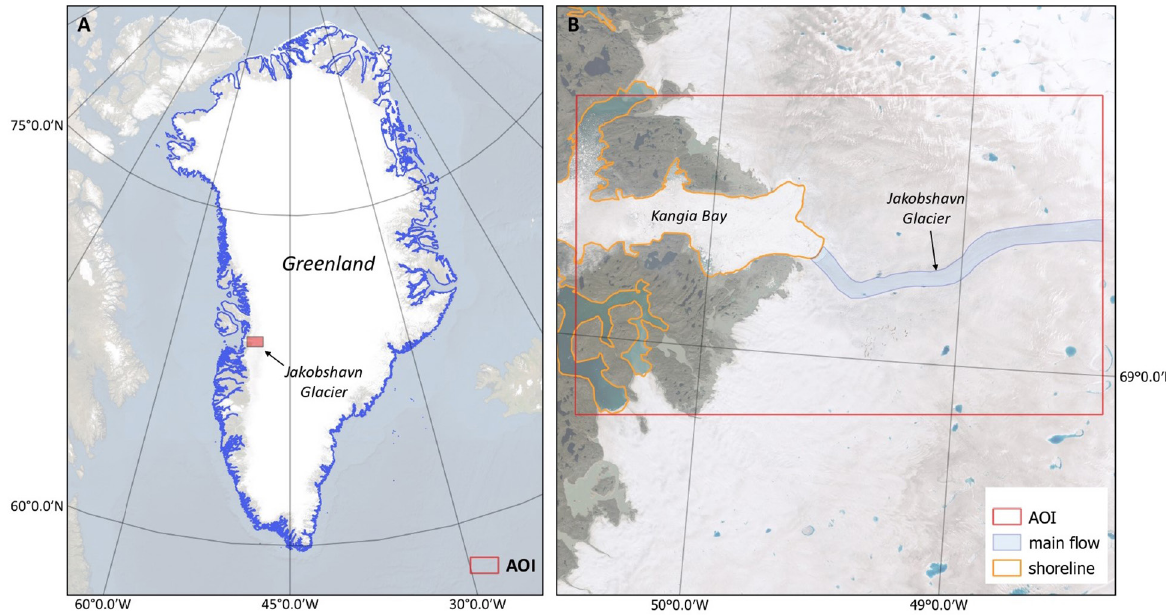
Fig. 1. Location of the area of interest (AOI): A) position of the Jakobshavn glacier on the Greenland map, B) precise location of the glacier near Kangia